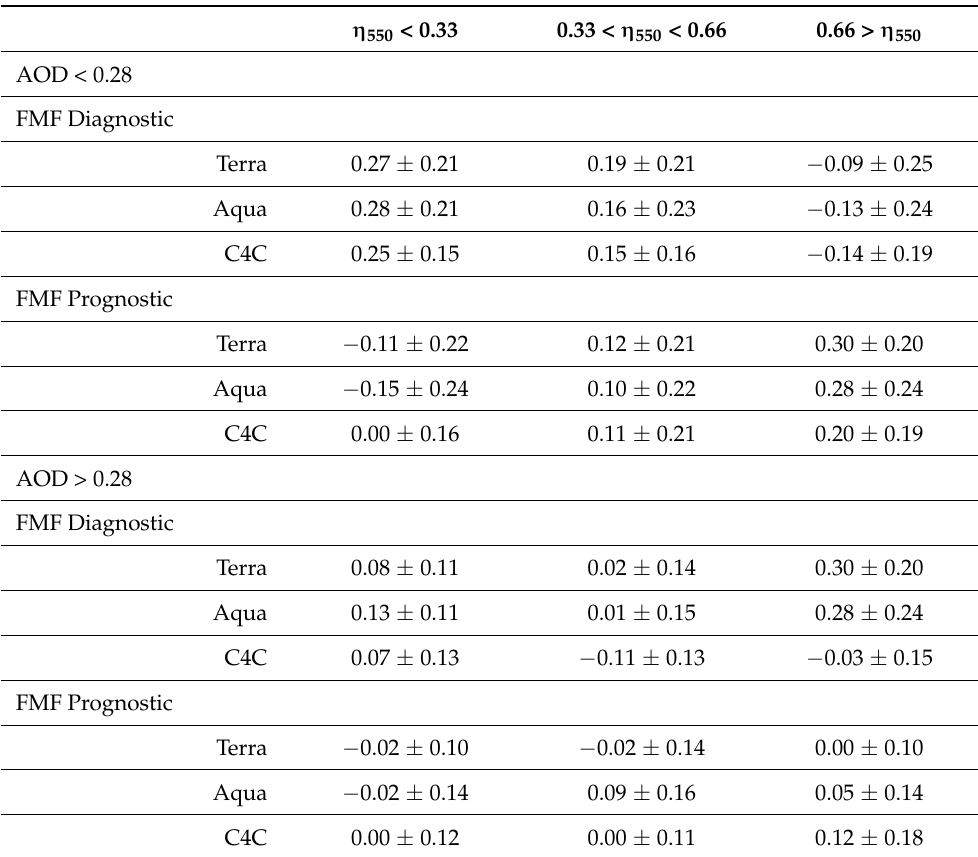
Table 2. Diagnostic and prognostic mean bias/root mean square error (RMSE)/root mean square deviation (RMSD) for fine mode fraction ( η 550 ) by group. Aggregations for diagnostic and prognostic error are as Table